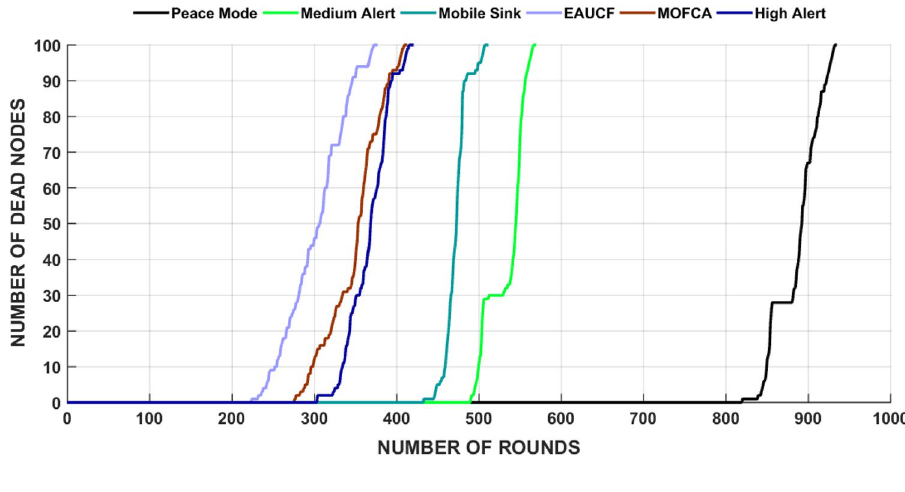
Fig. 10 Ratio of the number of dead nodes to the number of rounds in scenario 2, the second